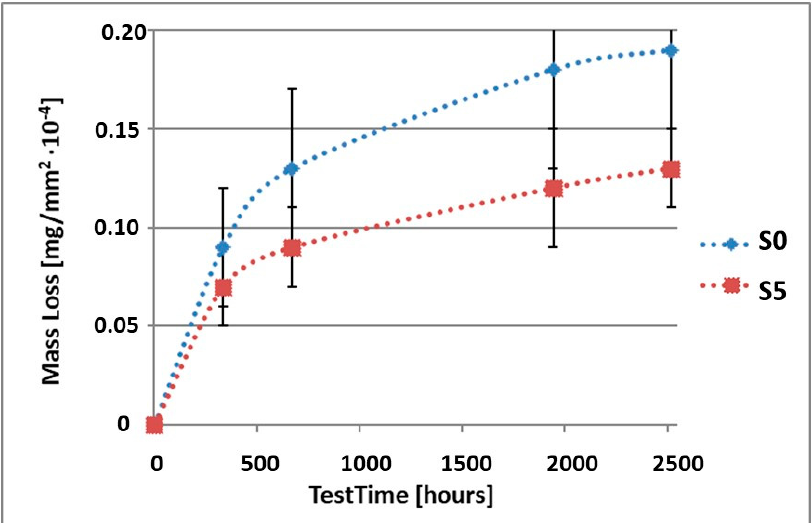
Figure 10. Comparison of the mass losses of samples S0 and S5 for tests in CASS environment.